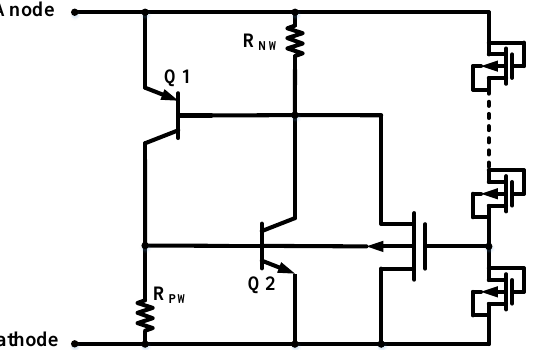
Figure 2. Equivalent circuit of the proposed ULVTSCR device.